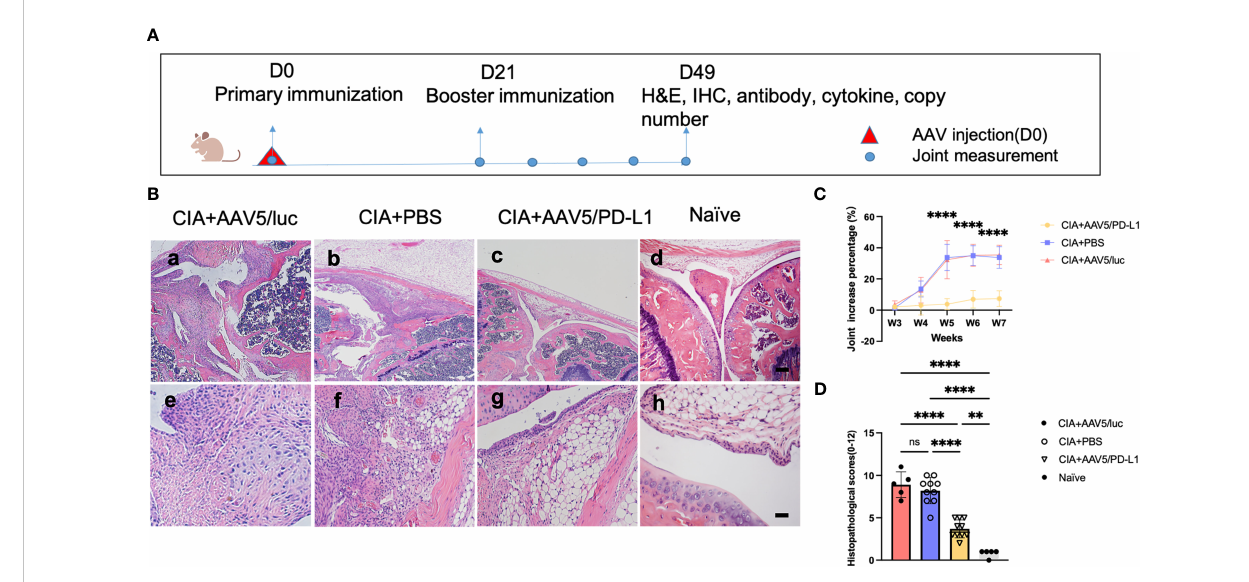
FIGURE 3 Improved knee joint swelling and decreased histological change in joints treated with AAV5/PD-L1 vectors as prophylaxis. (A) , Schematic diagram of animal experiment with intra-articular injection of AAV5/PD-L1 vectors as a prophylactic treatment, 1x10 10 particles of AAV5/PD-L1 vectors were injected into the left knees of CIA mice on day 0, while PBS or AAV5/luc was injected into the right knees of the same mice. On the same day, the primary immunization with type II collagen was applied, and on day 21, the booster immunization was applied. Knee joint size was measured weekly. At week 7, joints were collected for histology and cytokine analysis, and other tissues, including sera, liver, spleen, heart, lung, and kidney, were also harvested to evaluate systemic impact of PD-L1 expressed in the joints. (B) , joint histology analysis with H&E staining. Representative images of H&E staining from the CIA mouse knees injected with PBS, CIA mouse knees injected with AAV5/PD-L1, AAV5/luc or naïve mice at week 7 are shown (n=10, a-d, bar=200 m m; e-h, bar=20 m m). (C) , knee joint swelling change with PD-L1 prophylactic treatment. The knee joint sizes at different time points were measured and compared to those on day 0. Data is shown as means ± SEM (n=10). ****, p < 0.001. (D) , The knee joint histological score (n=10). Histopathological evaluation was performed and scored by two independent observers for the following changes: synovial hyperplasia, leukocyte in fi ltration, pannus formation, and cartilage necrosis/erosion. Each dot represents one mouse joint. Data is represented as means ± SEM. Data was analyzed using one-way ANOVA followed by Bonferroni multiple comparison test for group comparisons. **, p < 0.01, ****, p < 0.001. ns, not signi fi cant (p ≥